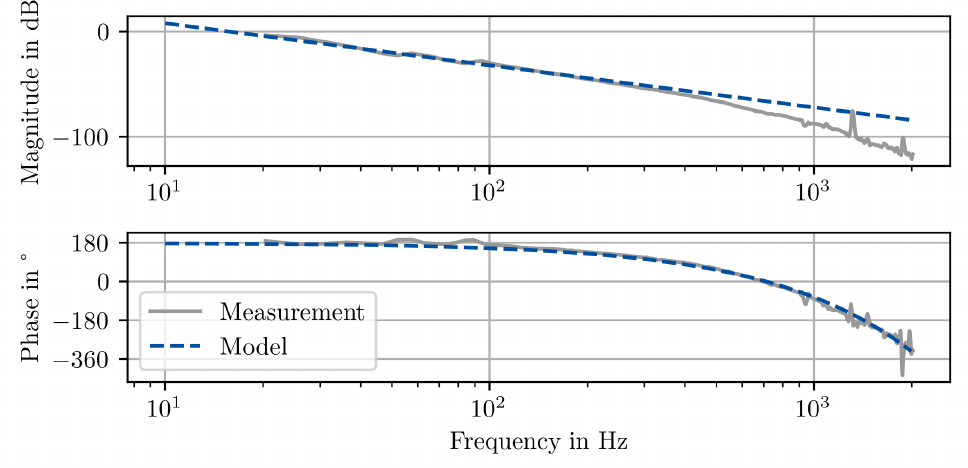
Figure 3. Comparison between plant model and measurement